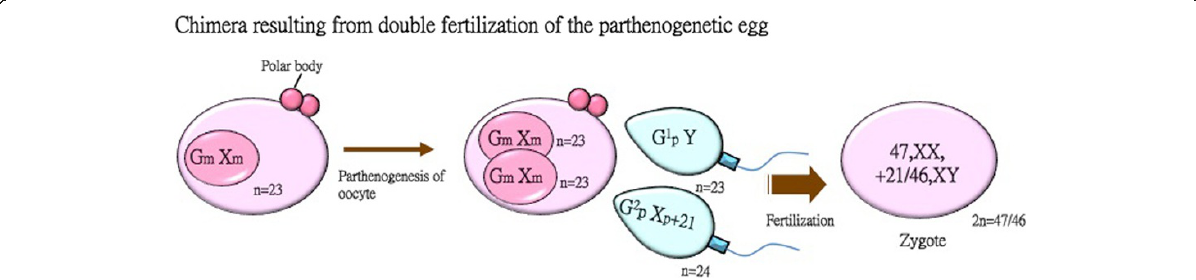
Figure 3 The mechanism of the formation of the present chimeric case with trisomy 21. This chimeric case could result from the fertilization of a parthenogenetic egg with two sperms, one (Y) sperm and one (X, +21)